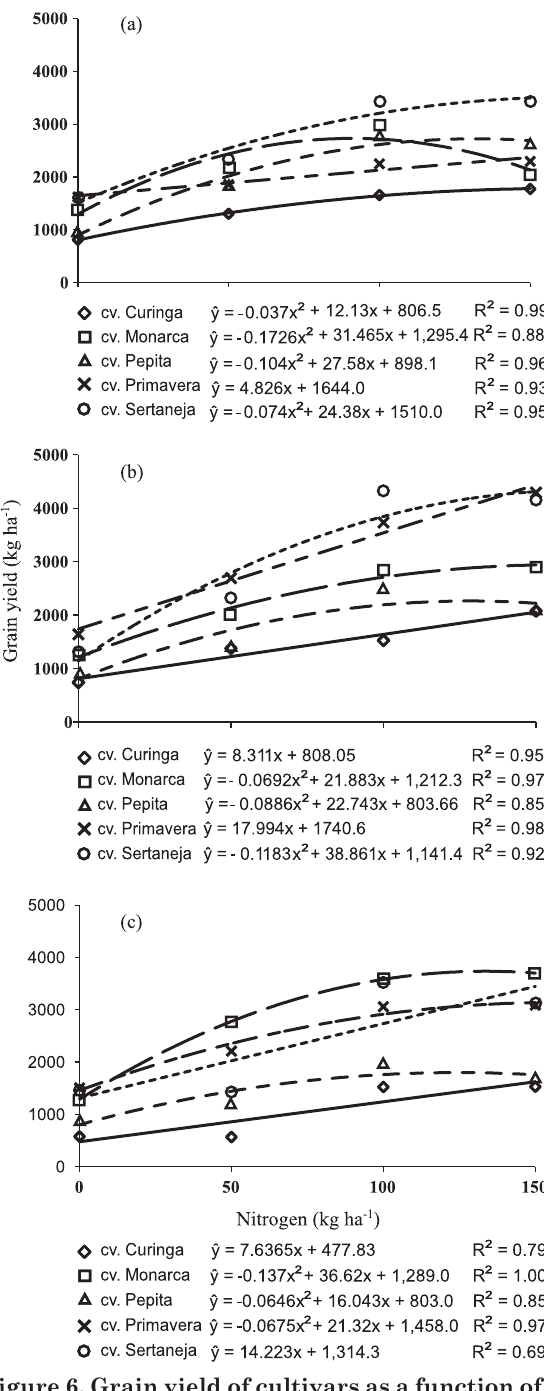
figure 6. grain yield of cultivars as a function of n rates and application times (a) 100 % at plan- ting; (b) 50 % at sowing – 50 % at tillering; and (c) 100 % at